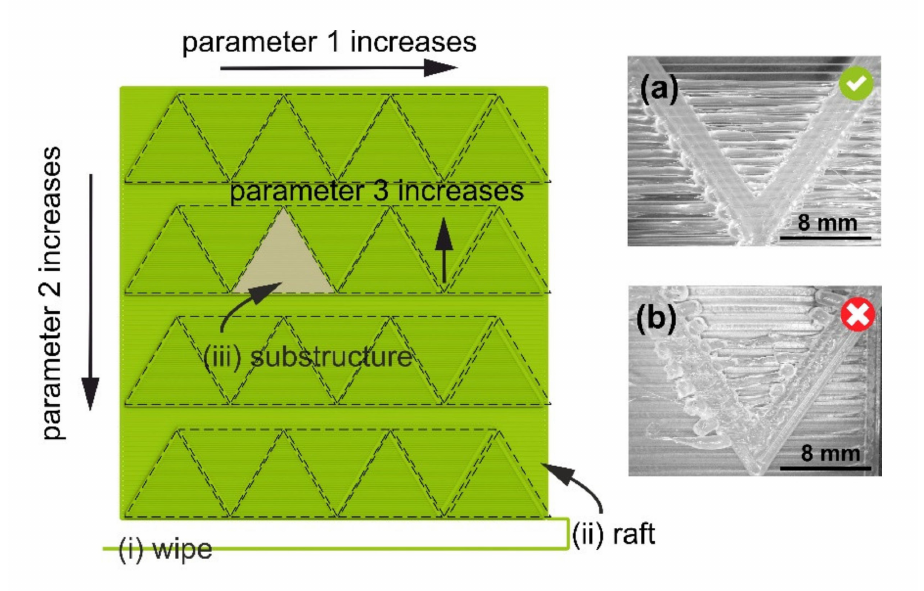
Figure 4. Test geometry for the bridging test (#11) consists of (top view) (i) a wipe strip, (ii) a square raft structure with zigzag walls (supporting substructures), and (iii) bridging test substructures of varying length. The values of the bridging extrusion multiplier (Parameter 1) increase from left to right, the bridging printing speed (Parameter 2) increases from top to bottom, and the bridging length (Parameter 3) increases within the substructure. Insets show micrographs of two substructures in a test for PA: ( a ) and ( b ) correspond to optimal (bridging extrusion multiplier of 2.0 and bridging printing speed of 35 mm / s) and non-optimal (bridging extrusion multiplier of 1.0, bridging printing speed of 25 mm / s) PP values, respectively. Other PP values: bead height, 0.20 mm; extrusion temperature, 268 ◦ C; printing speed, 25 mm / s; nominal bead width, 0.80 mm.